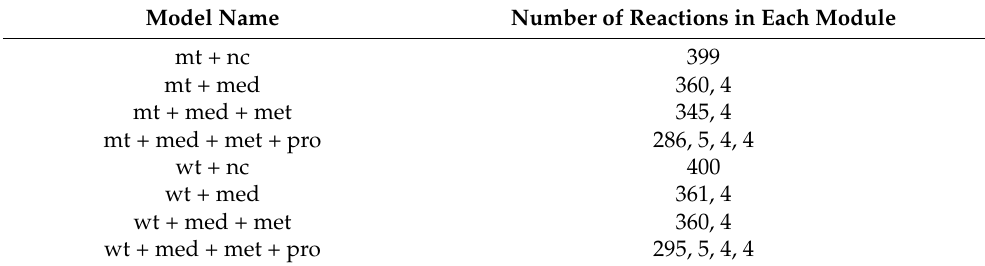
Table 2. The number of reactions in the existing modules in each model when their solution space was analysed with